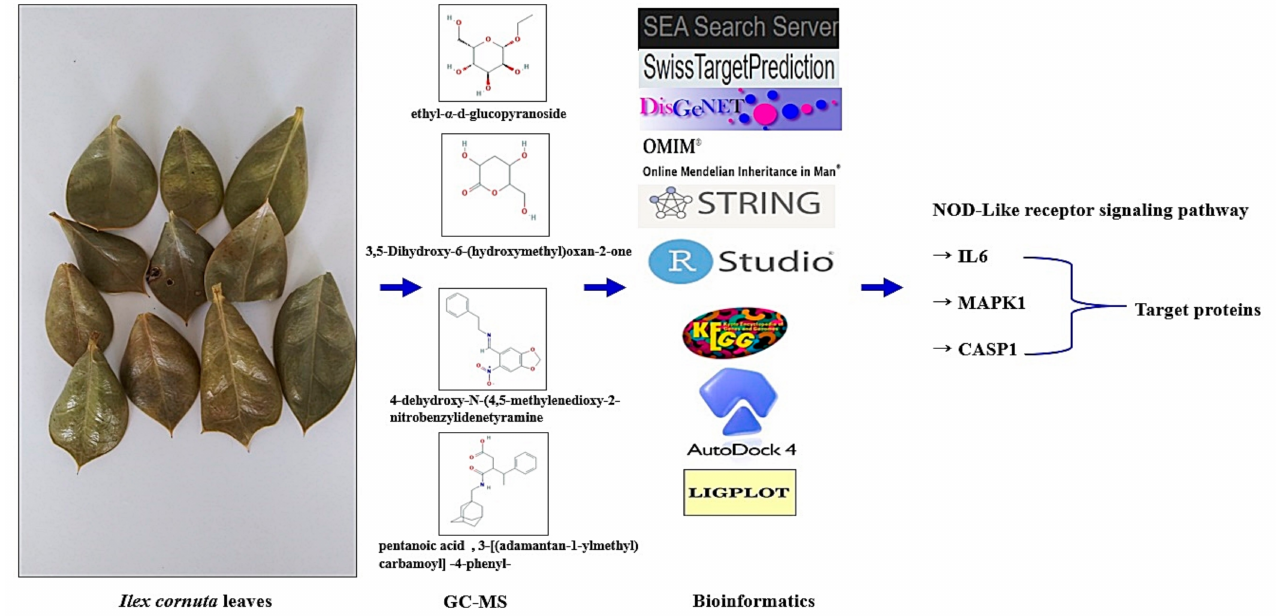
Figure 9. Summary figure of key findings in the